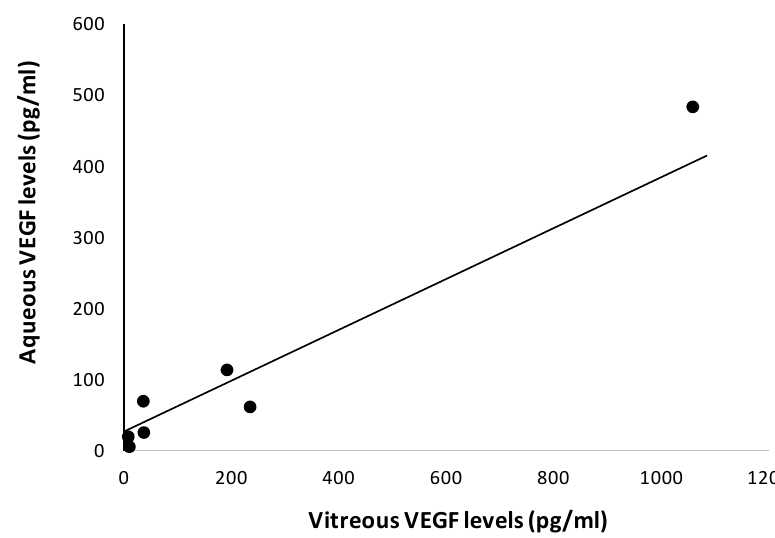
Figure 2. Correlation between aqueous and vitreous levels of VEGF.